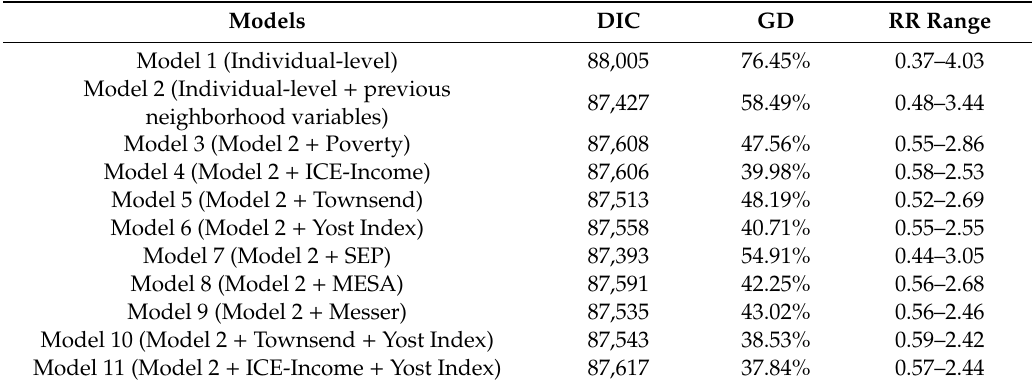
Table 3. Model Characteristics Comparing Model Fit (DIC), Relative Risk Range (RR) and Unexplained Geographic Disparity (GD)